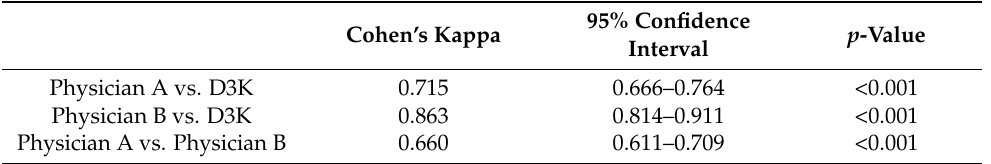
Table 10. Agreement analysis using Cohen’s